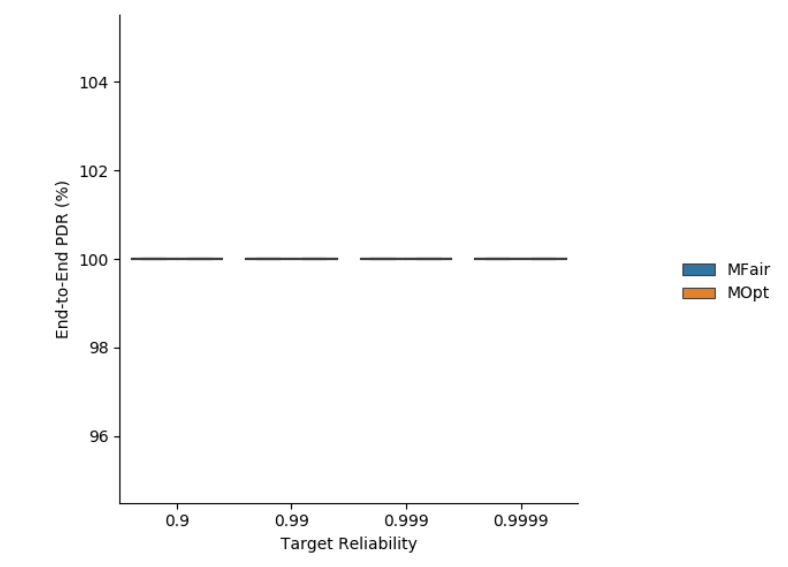
Figure 14. End-to-end delivery rate obtained with MFair and MOpt for MaxTrans = 20 transmissions.